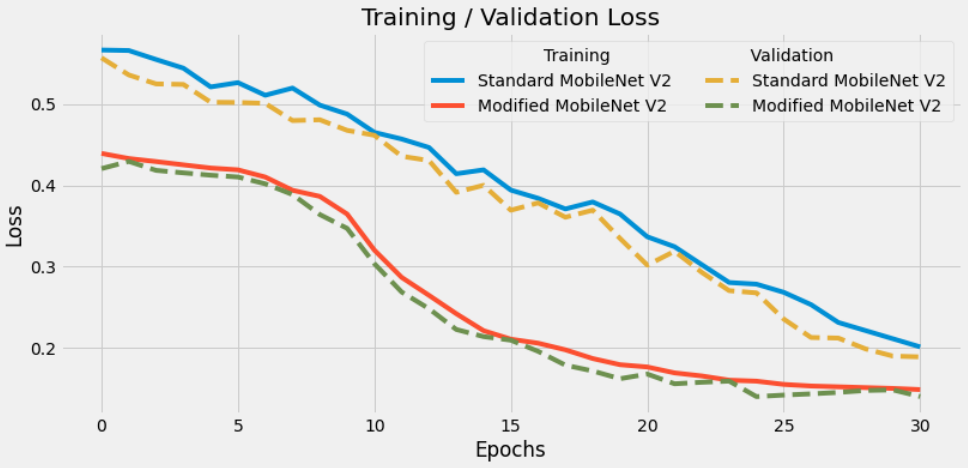
Figure 4. Comparison of training loss of standard MobileNetV2 and modified MobileNetV2. Our modified DL model has much lower loss in every epoch, illustrating its high optimized